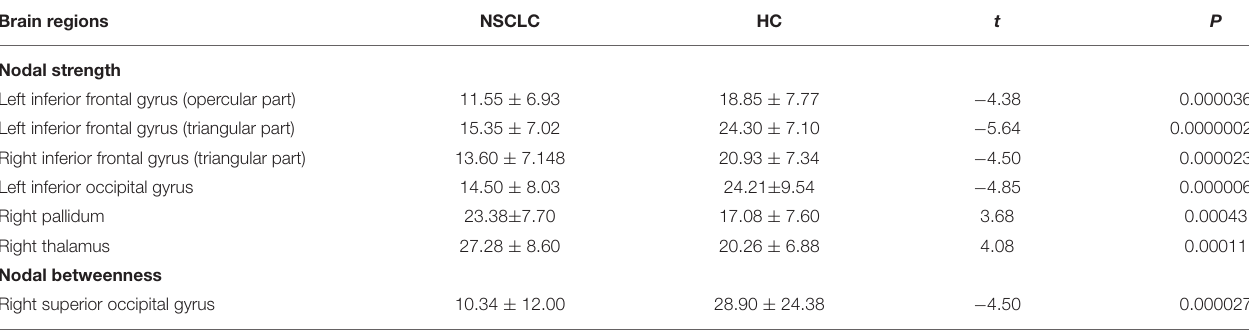
TABLE 2 | Brain regions showed altered nodal measures in the functional brain networks of patients with NSCLC. Brain regions Nodal